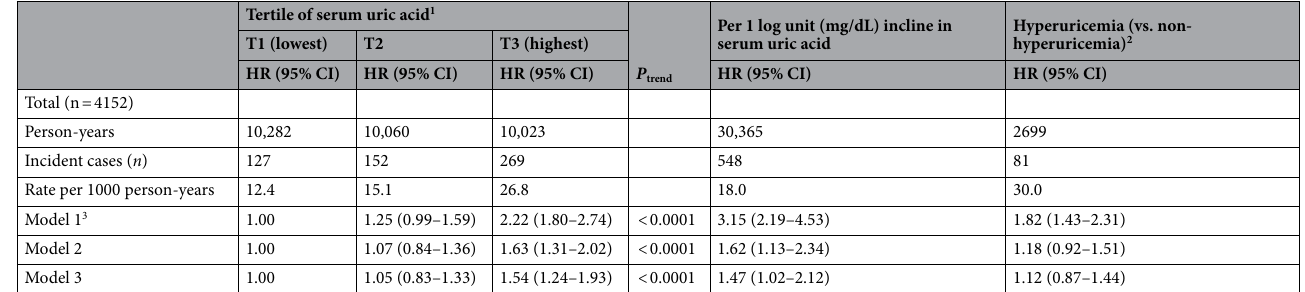
Table 2. Adjusted hazard ratios (with 95% confidence intervals) for type 2 diabetes according to serum uric acid levels in Korean adults aged 45–76 years. T tertile; HR hazard ratio; CI confidence interval. 1 Cut-offs for tertiles 1–3 of serum uric acid levels are as follows: < 5.2, 5.2–6.1, and > 6.1 mg/dL in men and < 3.8, 3.8–4.4, and > 4.4 mg/dL in women, respectively. 2 Hyperuricemia is defined as serum uric acid levels ≥ 7 mg/dL in men and ≥ 6 mg/dL in women. 3 Model 1: adjusted for sex (men or women) and age (years); Model 2: additionally adjusted for area of residence (Ansan or Ansung), education level (≤ elementary school, middle/high school, or ≥ college), smoking status (never, past, or current), alcohol consumption (g/d), regular physical activity (yes or no), body mass index (kg/m 2 ), waist circumference (cm), systolic and diastolic blood pressure (mmHg), triglyceride (mg/dL), total cholesterol (mg/dL), high-density lipoprotein cholesterol (mg/dL) and fasting blood glucose level (mg/dL), and family history of diabetes (yes or no); Model 3: additionally adjusted for log- transformed hs-CRP levels.